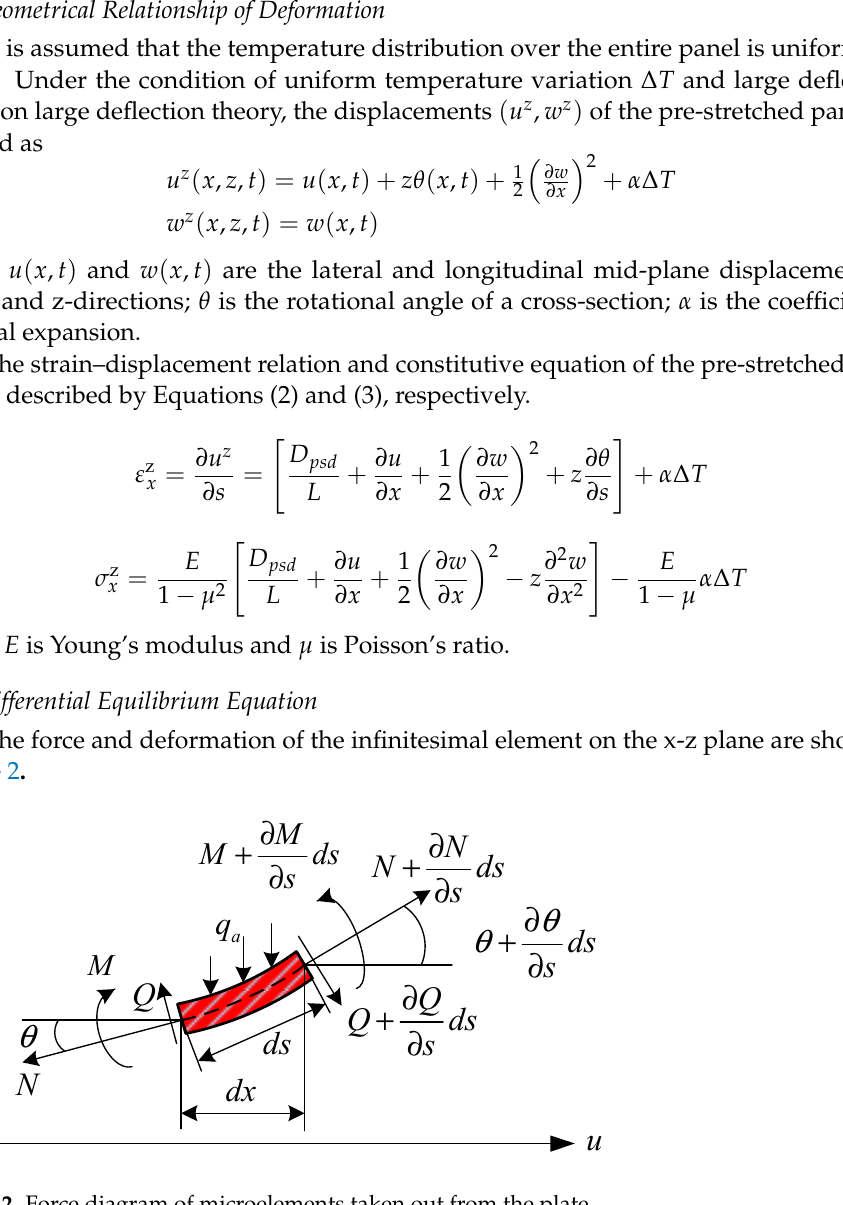
Figure 2. Force diagram of microelements taken out from the plate. Considering the force equilibrium in the z-direction, the transversal dynamic equation of the infinitesimal element can be given in the following form: